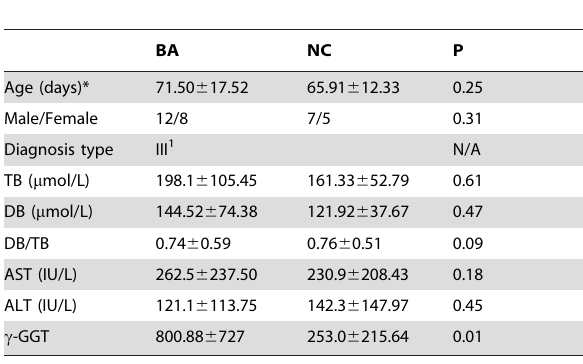
Table 1. Distribution of study subjects and liver function